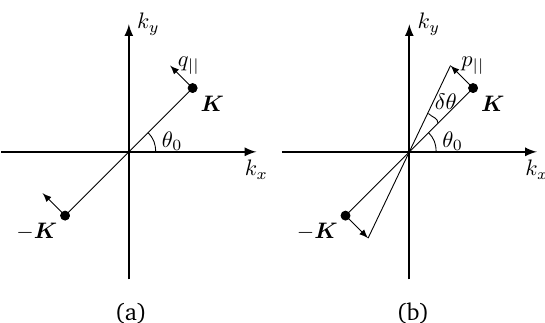
Figure 13: The relative change in momentum between the two valleys for (a) adding momentum to the particles to find the dispersion, (b) changing the direction of the surface by a δθ